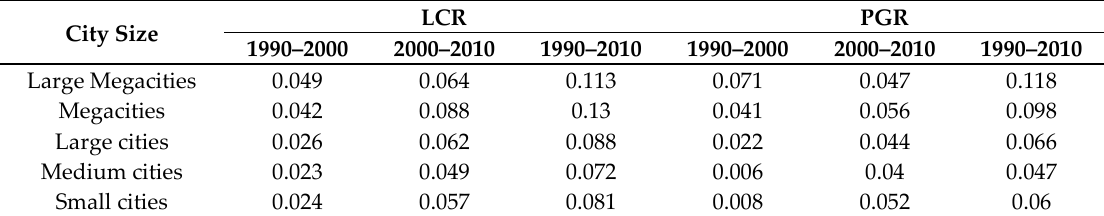
Table 3. The average value of LCR and